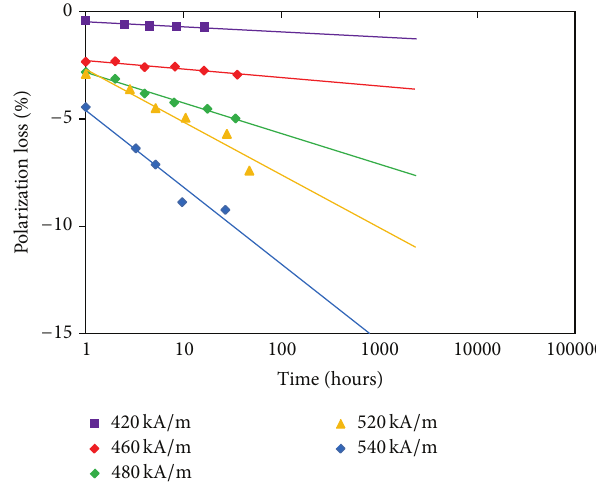
Figure 7: Polarization losses as a function of time at different demagnetizing fields in material 2 magnets at 120 ∘ C.